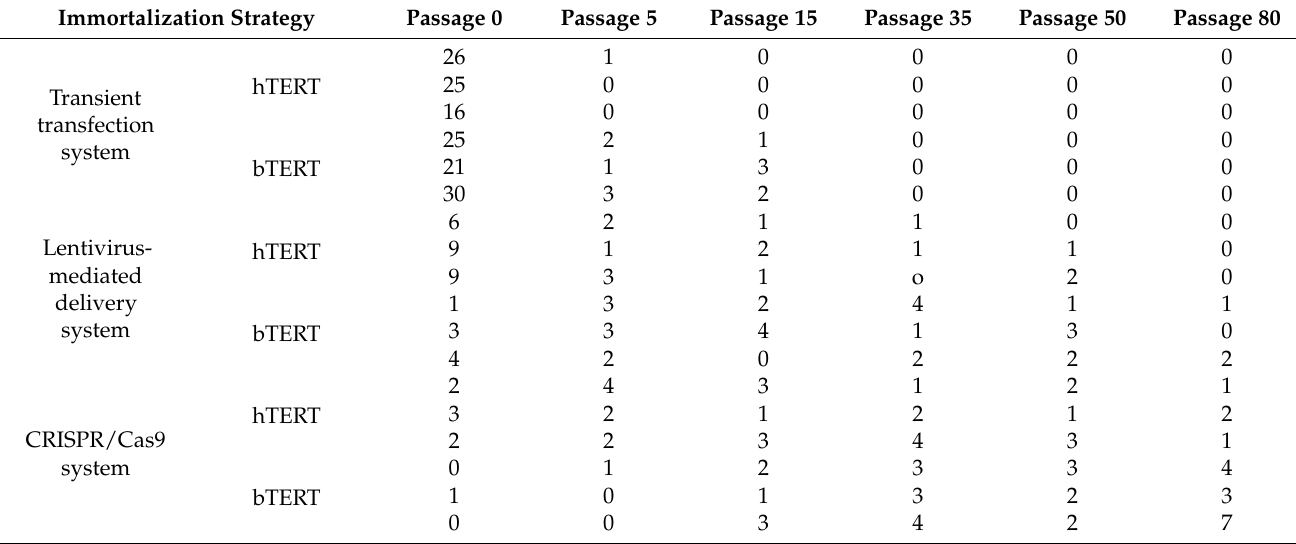
Table 2. Statistics of the number of BFFs colonies generated by the introduction of h TERT or b TERT via transient transfec- tion, lentivirus-mediated delivery, and HMEJ-based CRISPR/Cas9-mediated integration, which cultured no more than 0 generation, 5 generations, 15 generations, 35 generations, 50 generations, and more than 80 generations. Immortalization